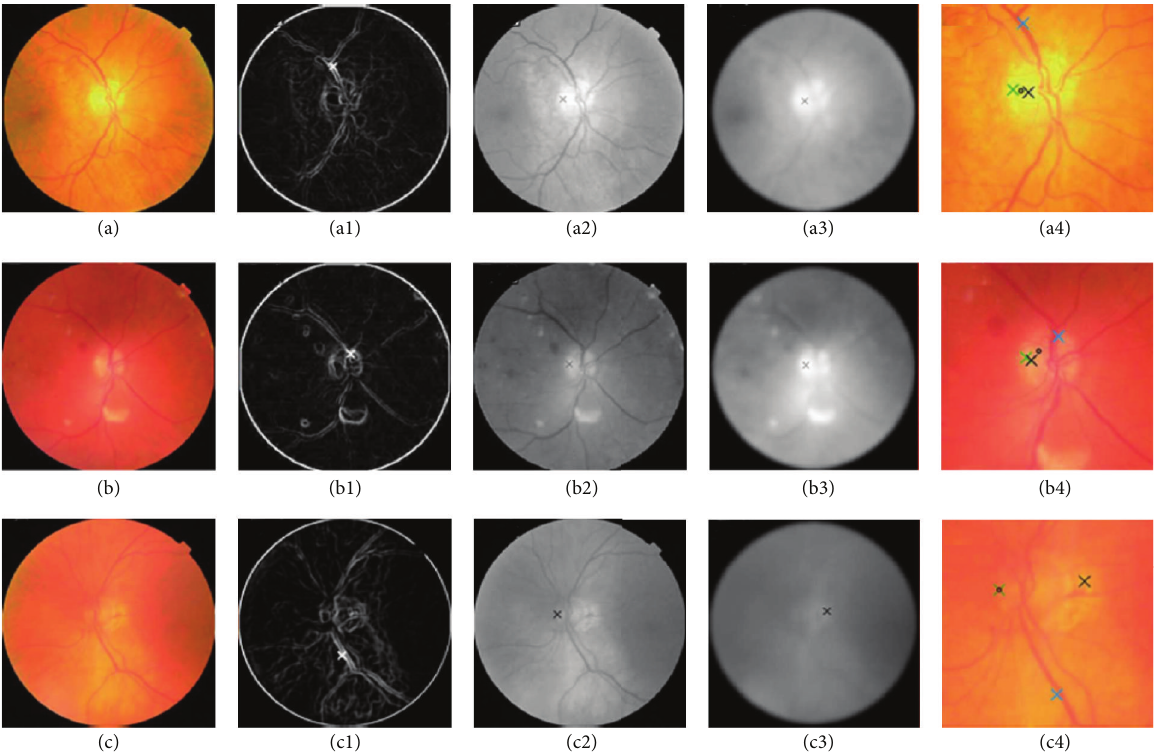
Figure9:ODPdetermination.((a),(b),and(c))Originalimages.((a1),(b1),and(c1))ODpixelsprovidedbythemaximumdifferencemethod. ((a2), (b2), and (c2)) OD pixels provided by the maximum variance method. ((a3), (b3), and (c3)) OD pixels provided by the low-pass filter method. ((a4), (b4), and (c4)) Final ODP